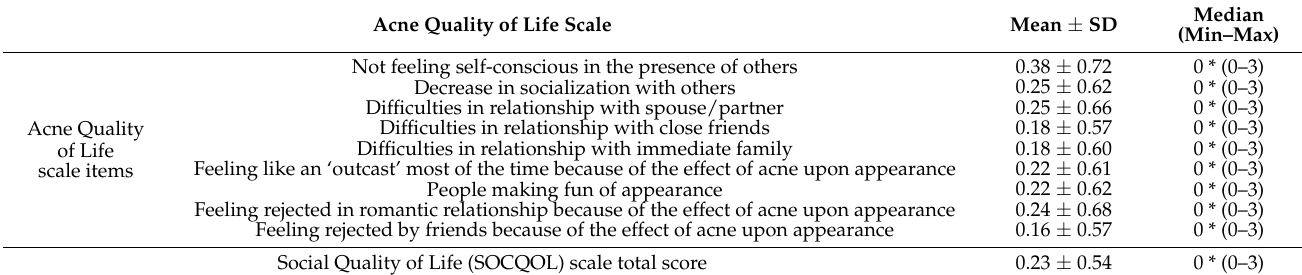
Table 2. The results of the Social Quality of Life (SOCQOL) Score obtained based on the Acne Quality of Life (AQoL) scale in the studied group of male adolescent participants of the